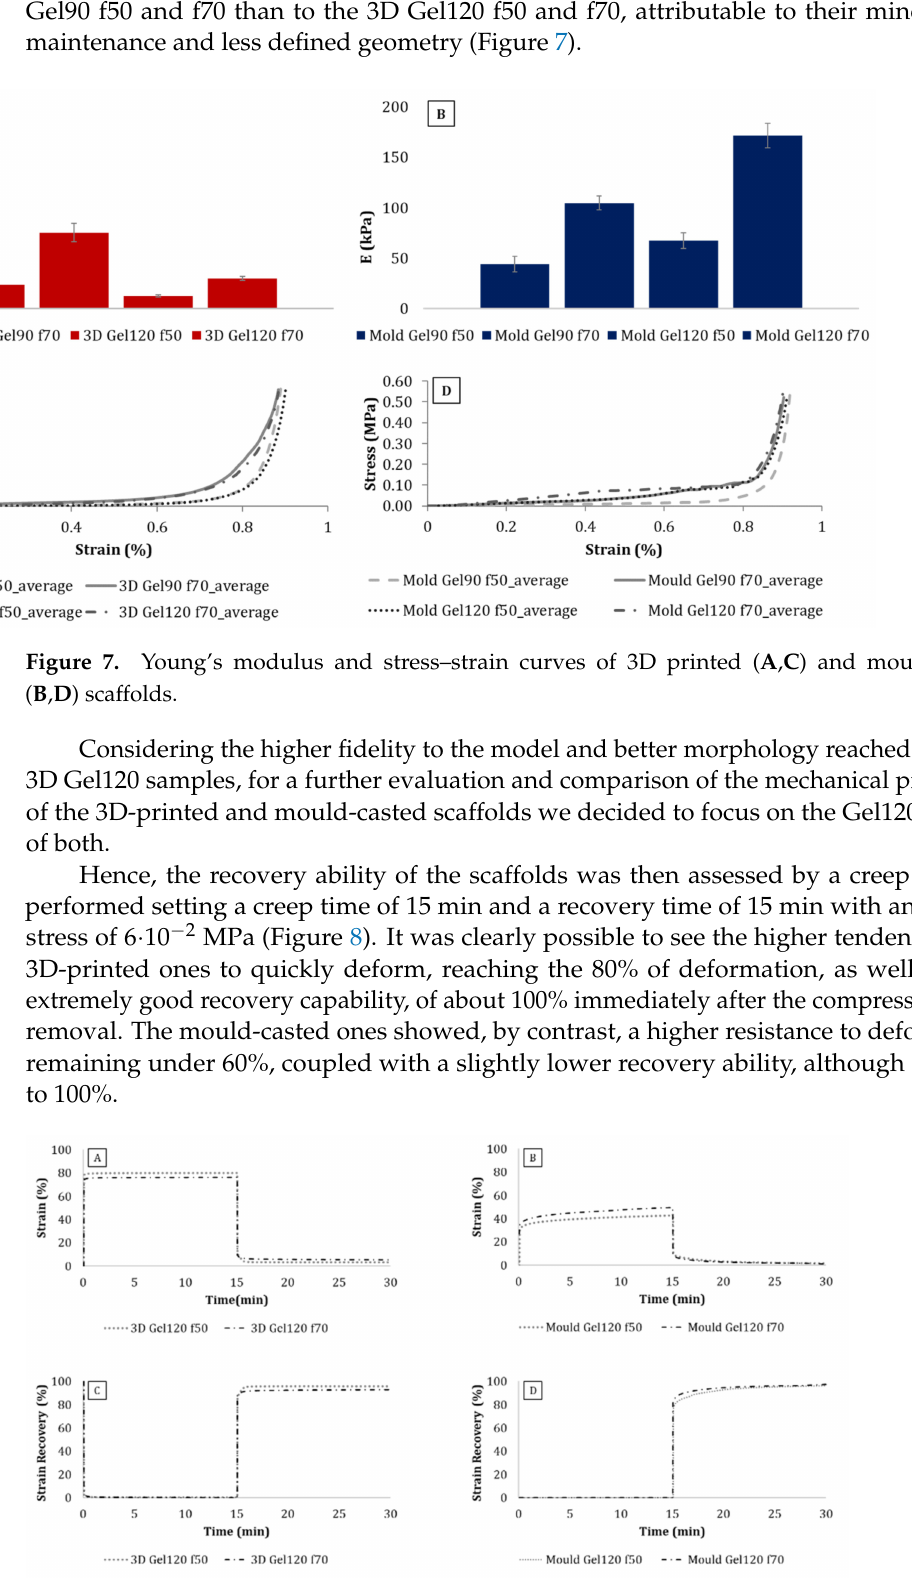
Figure 8. Compression resistance ( A , B ) and recovery ability ( C , D ) evaluation and comparison of the 3D-printed and mould-casted